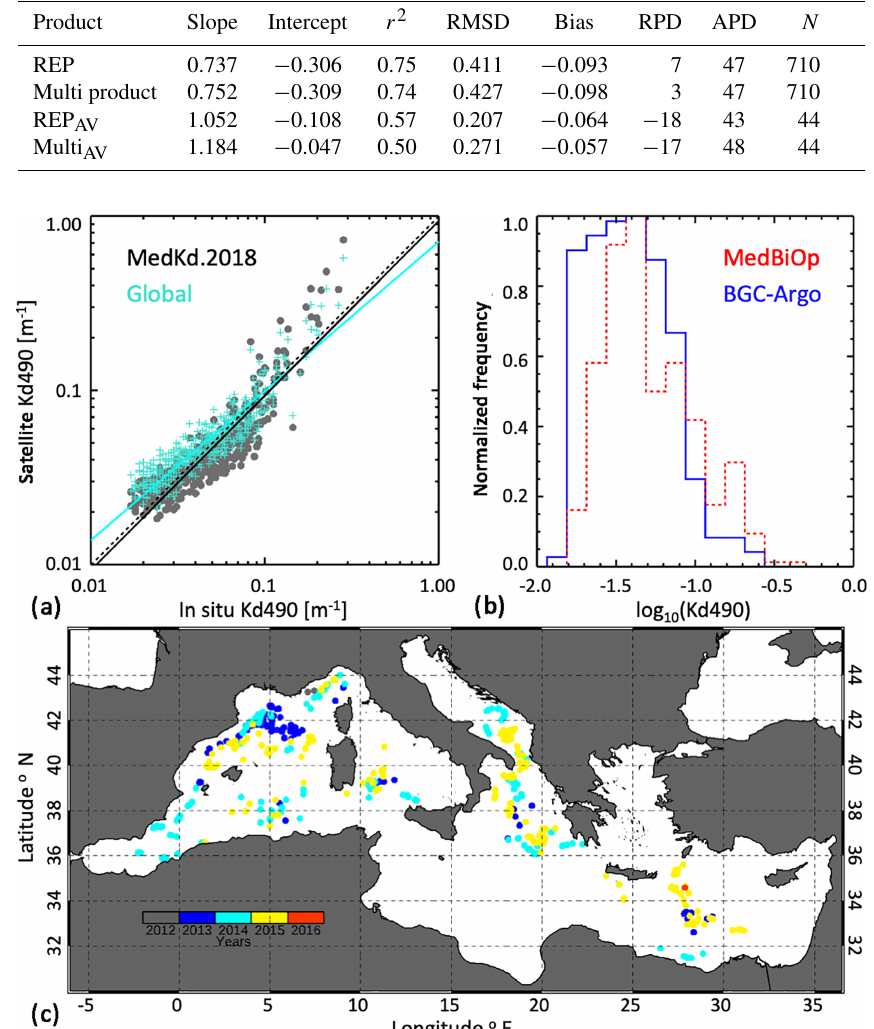
Table 5. Statistics about the Chl (mgm − 3 ) matchup datasets described in Fig. 10. The first two rows refer to the comparison of the two satellite multi-sensor products with the entire MedBiOp Chl dataset, while the last two refer to the statistics associated with matchups on the period in which VIIRS and MODIS coexist (REP AV and Multi AV ). A more comprehensive table of metrics is provided in the Supplement (Table S8).